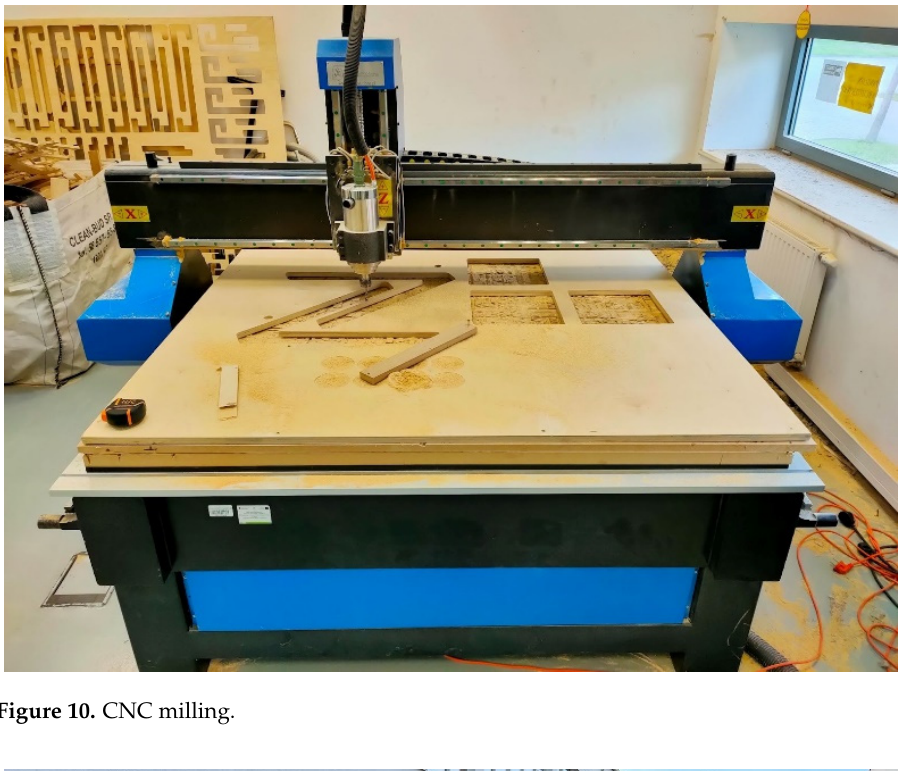
Figure 10. CNC milling.